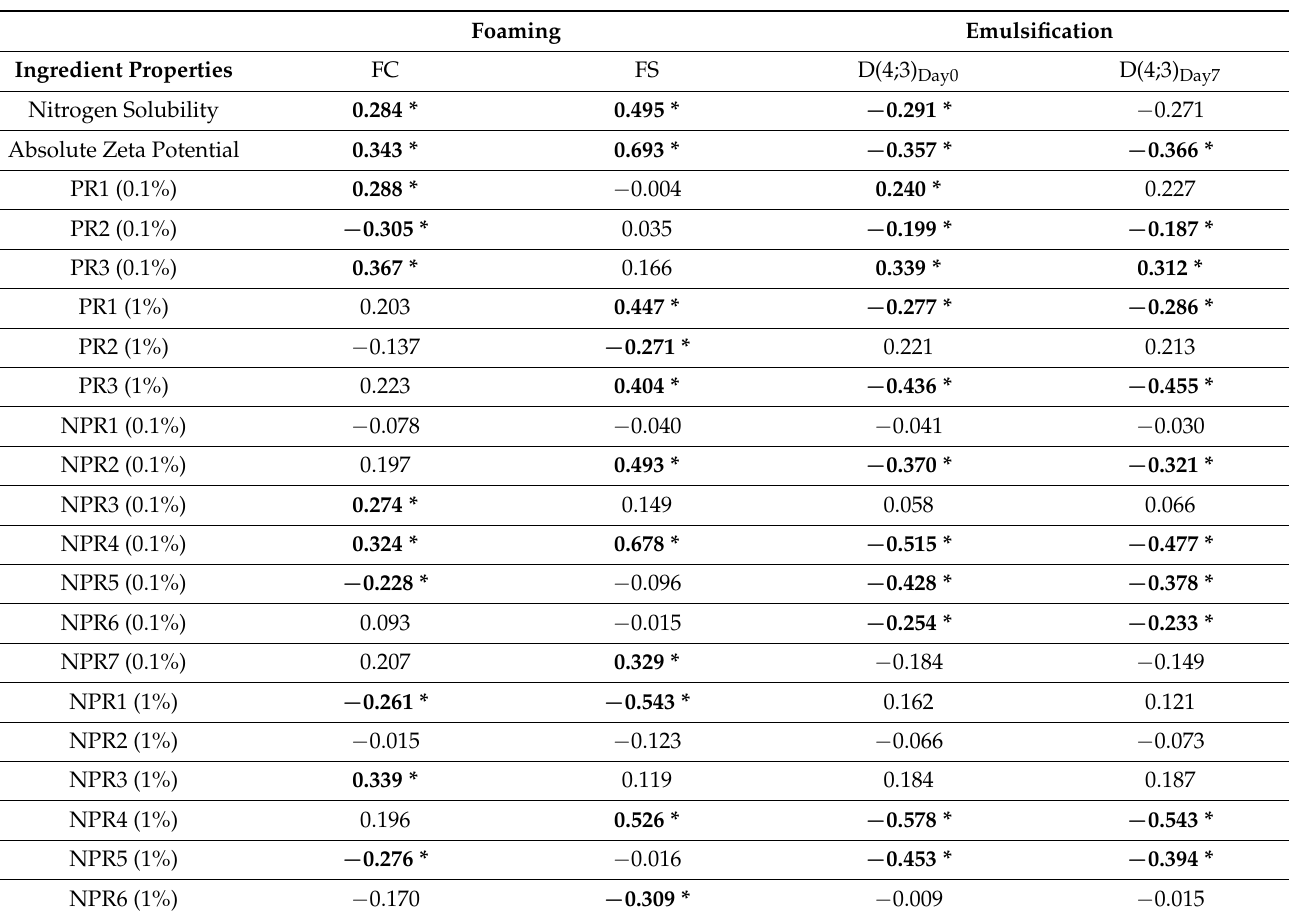
Table 1. Pearson’s correlation analysis between foam (FC and FS) and emulsion (D(4;3)) properties and protein and non-protein